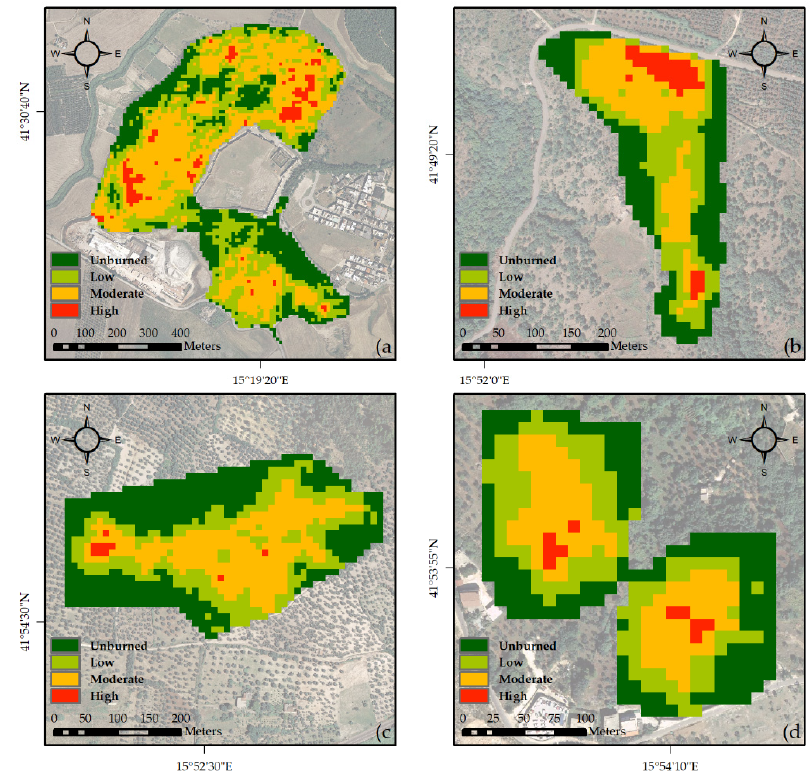
Figure 2. Fire severity classification (high, moderate, low, and unburned) for each study site: ( a ) LUC, Lucera site; ( b ) CAR, Carpino site; ( c ) ISC_1, Ischitella site; ( d ) ISC_2, Ischitella site.